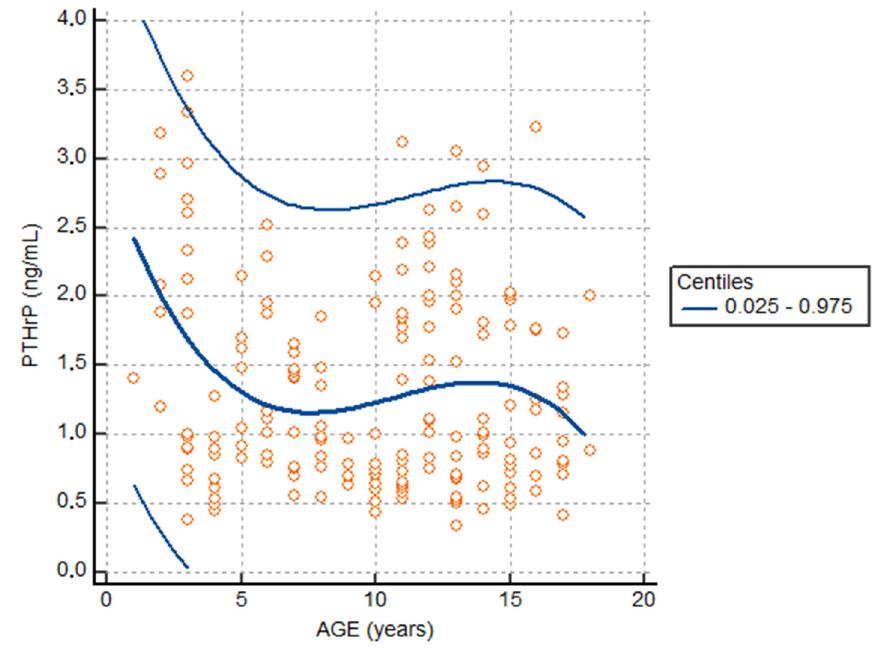
Figure 4. Plot scatter diagram of the measurements versus age. The calculated mean (central line) and centile curves.